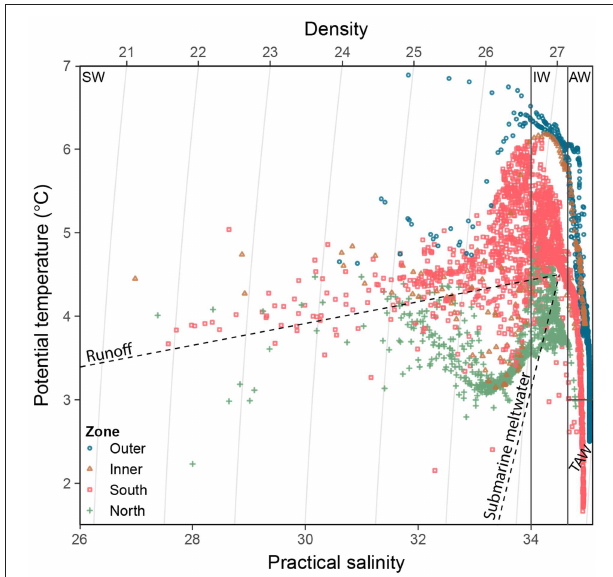
FIGURE 3 | Temperature-salinity diagram of CTD data for each zone. Water mass classification is according to Cottier et al. (2005). Water mass type abbreviations: SW, Surface Water; IW, Intermediate Water; AW, Atlantic Water; TAW Transformed Atlantic Water. Dashed lines represent runoff mixing line (subglacial and supraglacial meltwater discharges, near horizontal, towards 0 ◦ C and 0 salinity) and submarine meltwater mixing line (formed through melting along the glacier front, near vertical towards − 90 ◦ C and 0 salinity; Mankoff et al.,